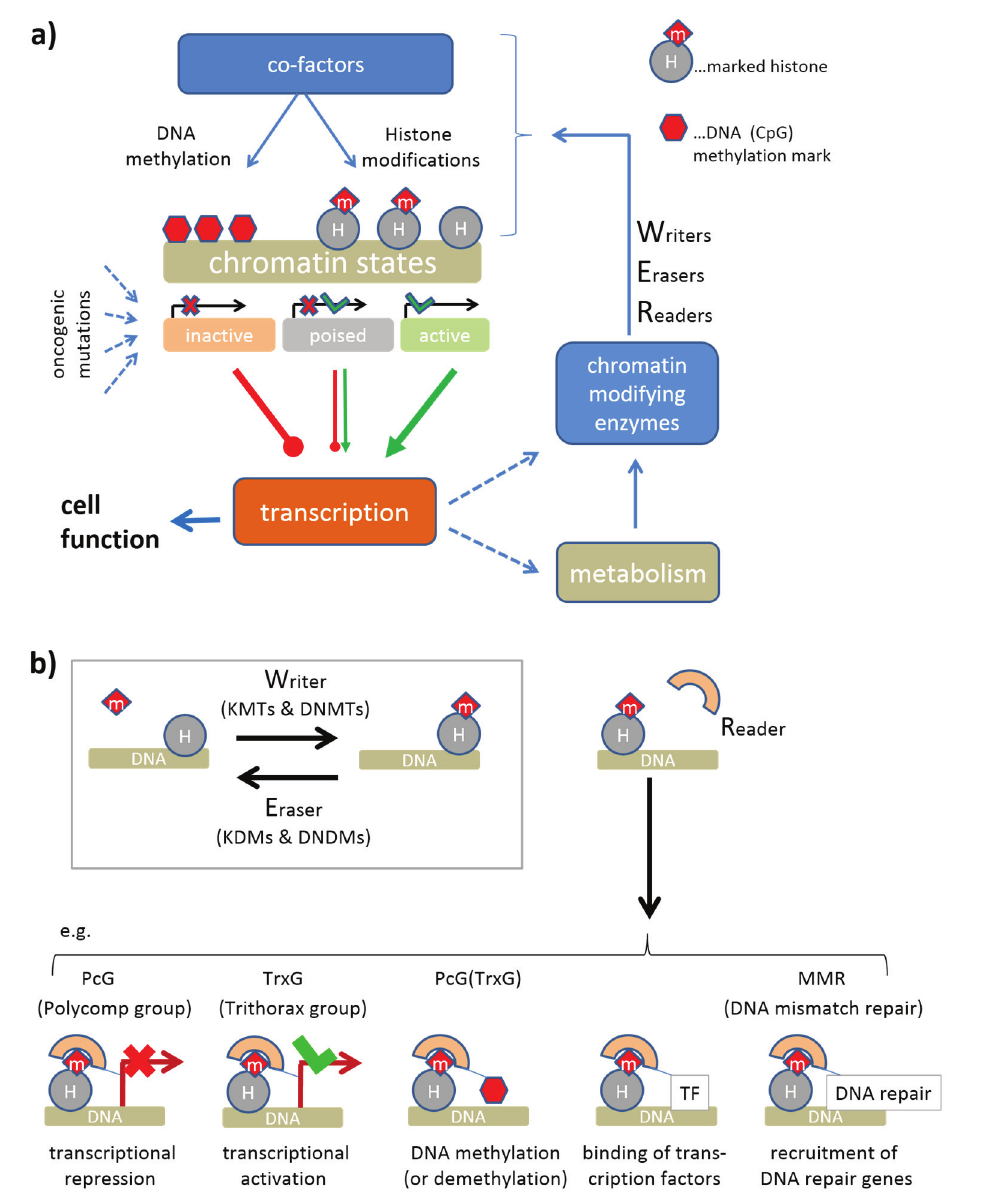
Figure 1. ( a ) Circuit of epigenetic regulation by chromatin modifiers: Different chromatin states are induced by a battery of histone modification, which in concert with DNA